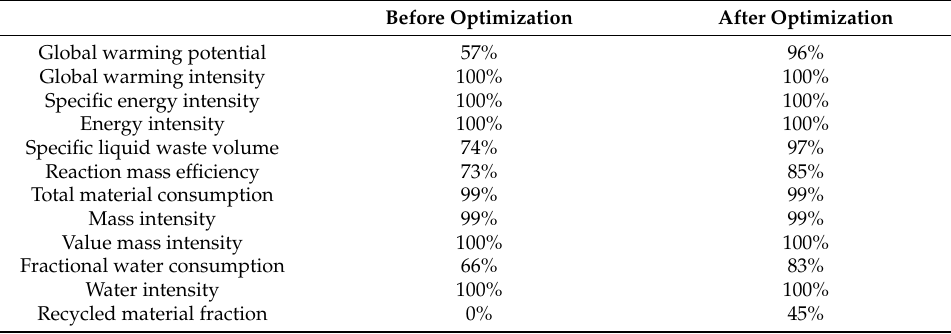
Table 4. Scores calculated before and after optimization of the